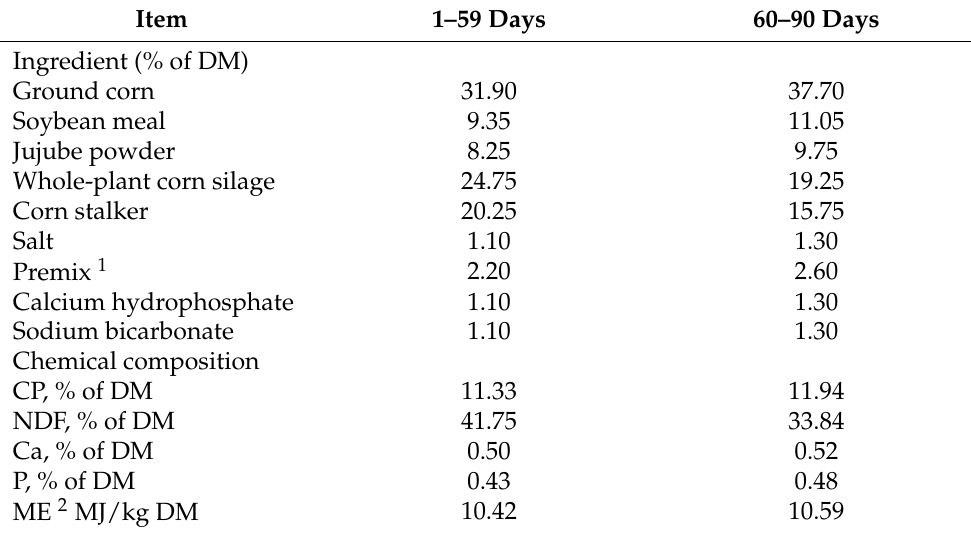
Table 1. Diet formulation and nutrient composition (DM basis) of the basal